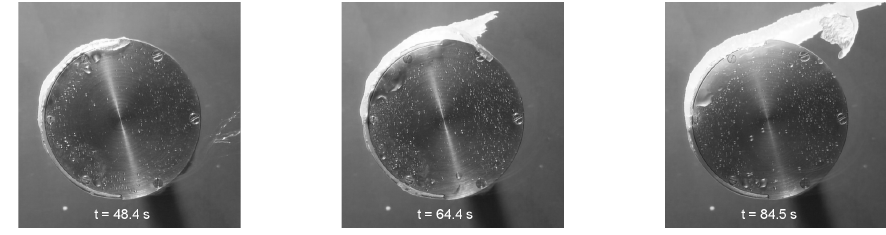
Figure 32. Side view of ice accretion when heating the cylinder, T ∞ = − 5 ◦ C, TWC = 6.8gm − 3 and m r = 0 .